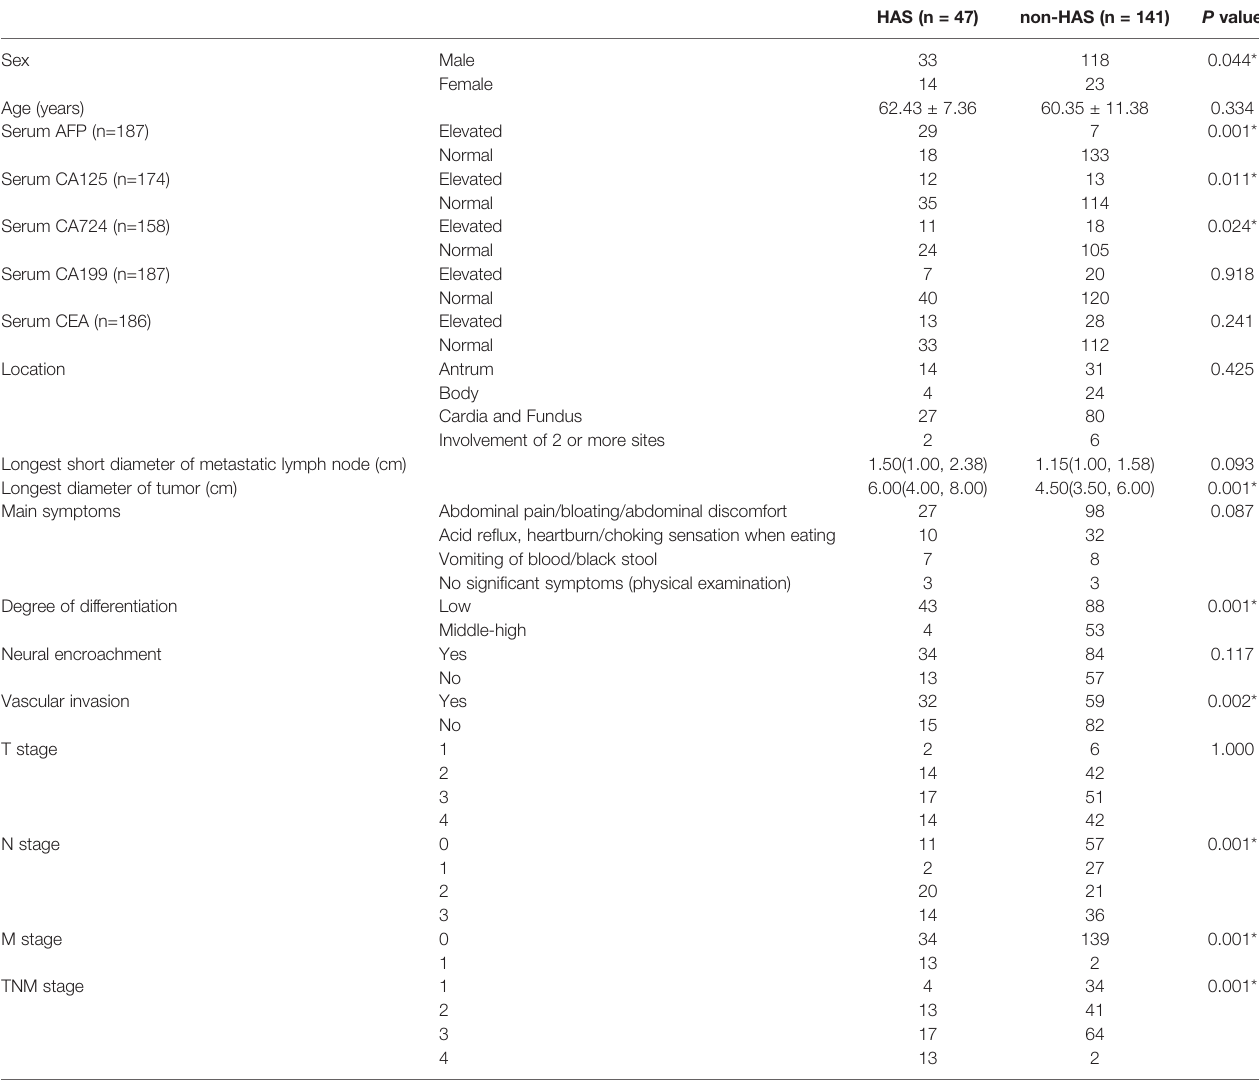
TABLE 1 | Comparison of clinical pathology information between HAS and non-HAS n = 188.